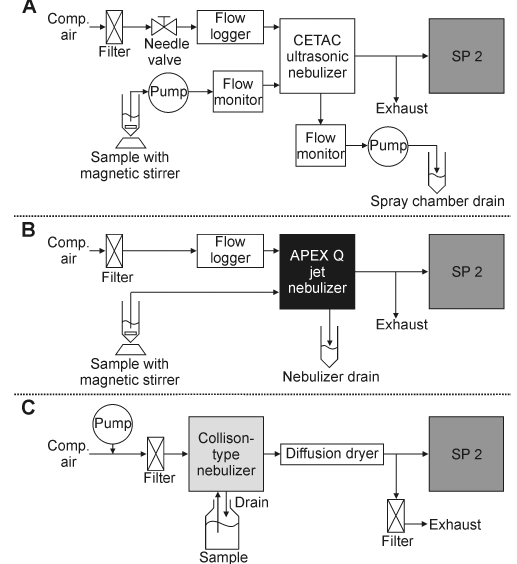
Figure A1. Instrumental setup for black carbon analysis of aqueous samples with the SP2: (A) ultrasonic (CETAC), (B) jet (Apex Q) and (C) Collison-type (PSI, built in-house) setup. Comp. air stands for compressed air.